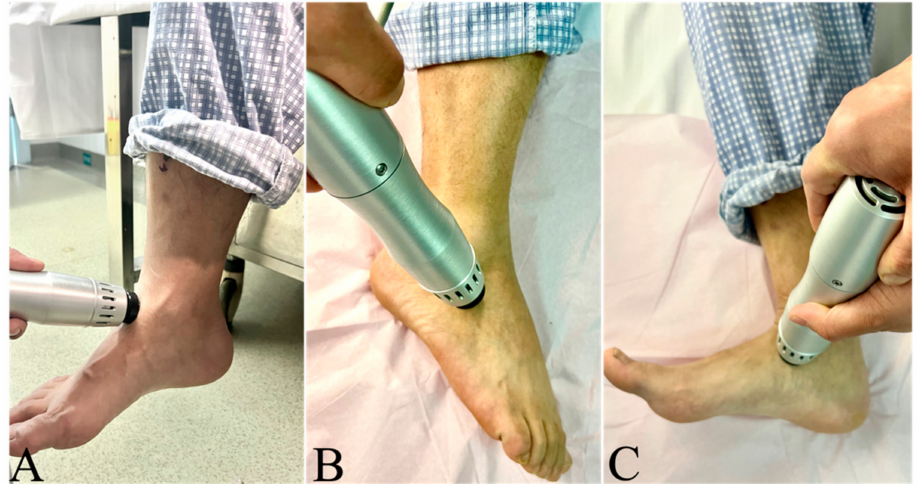
Figure 1. OLT patients’ position during ESWT ( A ) ESWT was applied in a neutral position when the OLT was in the talus dome; ( B ) the patient was in a lateral decubitus position with ankle flexion when the OLT was in the lateral surface of the talus; ( C ) the patient was in a lateral decubitus position with ankle extension when the OLT was in the medial surface of the